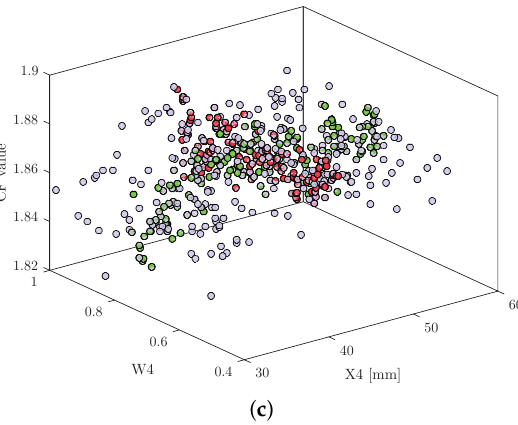
Figure 4. Sensitivity analysis of the Cost Function (CF) value to: ( a ) the position of the control point X4; ( b ) the weight of the control point W4; and ( c ) both sensitivities. Sensitivity analysis using a B-spline model with seven control points.